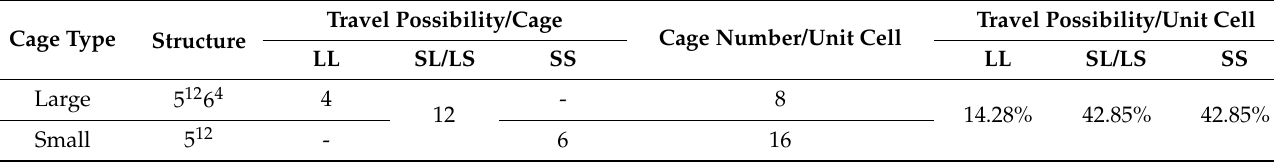
Table 2. Hydrate type II structural information and hopping-path possibilities. The diffusion between two large cages or between two small cages is labelled as LL and SS, respectively. Diffusion from a large cage to a small cage, and from a small cage to a large cage is labelled as LS and SL,